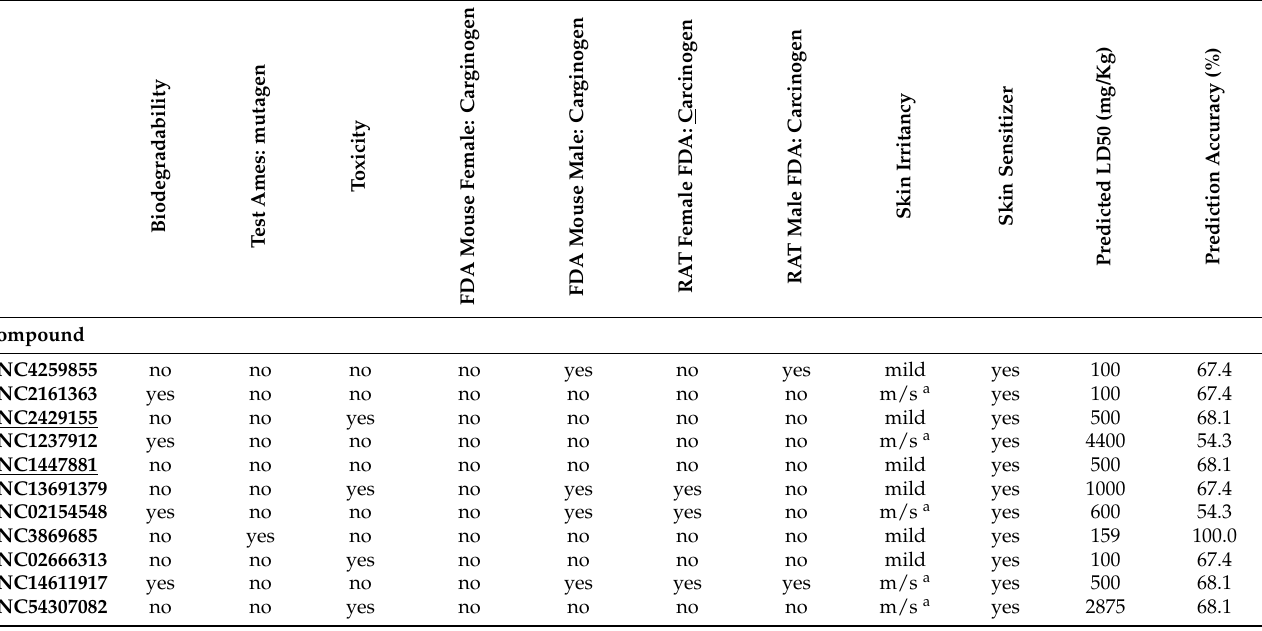
Table 2. Toxicity profiles of the selected compounds.